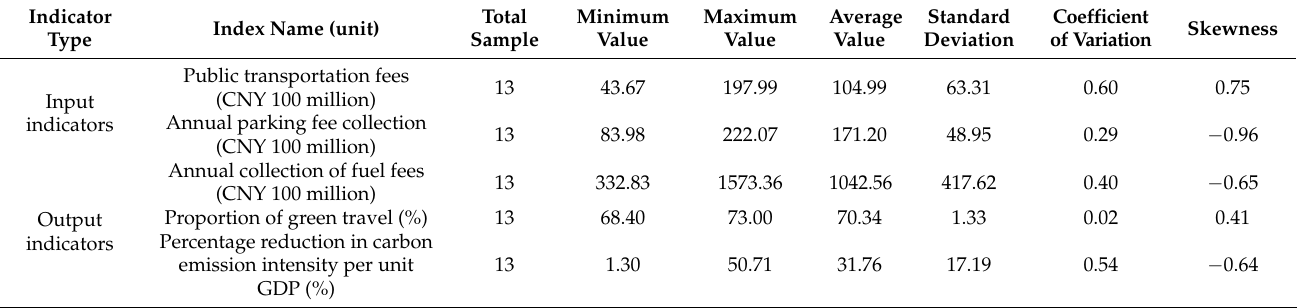
Table 3. Statistical description of input and output